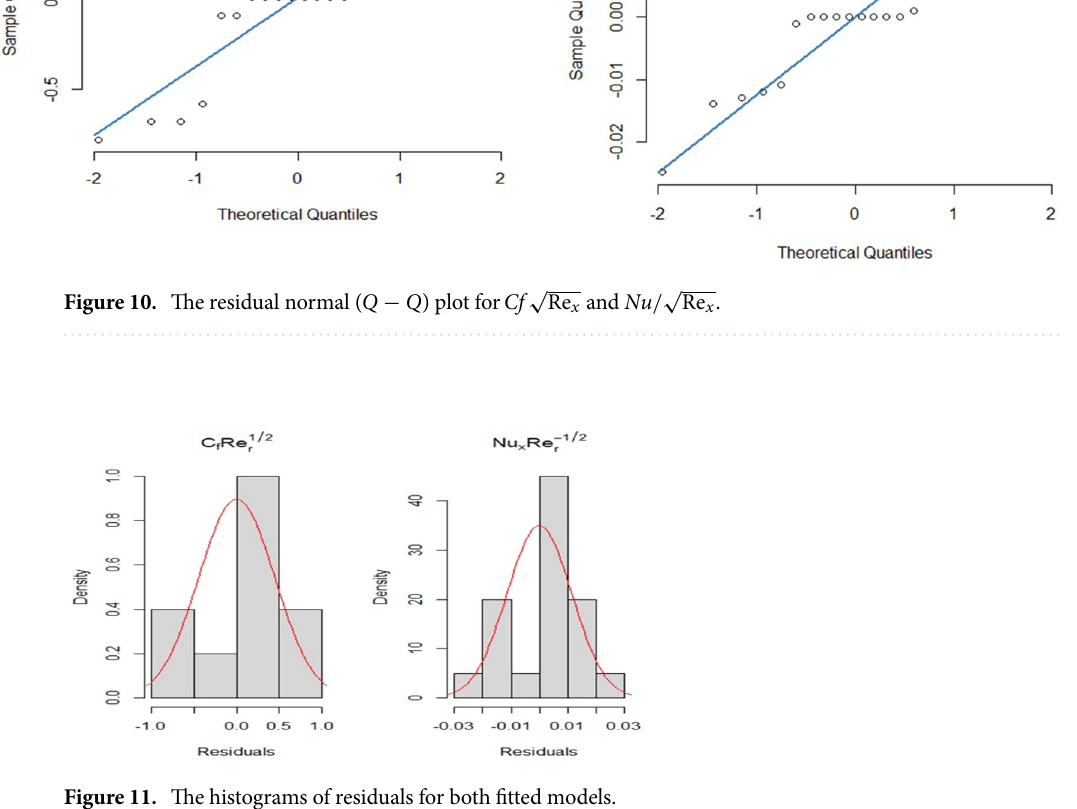
Figure 11. The histograms of residuals for both fitted